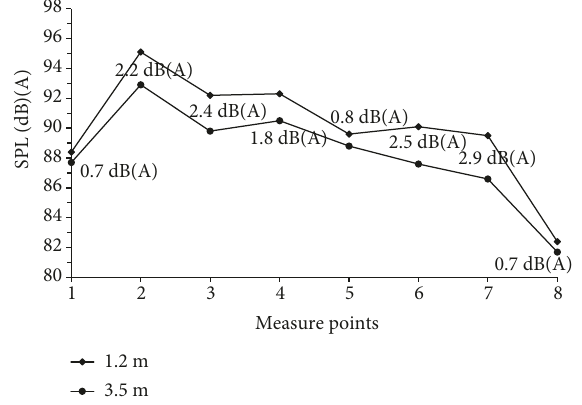
Figure 18: Comparison of sound pressure levels of monitoring points 7.5m far.